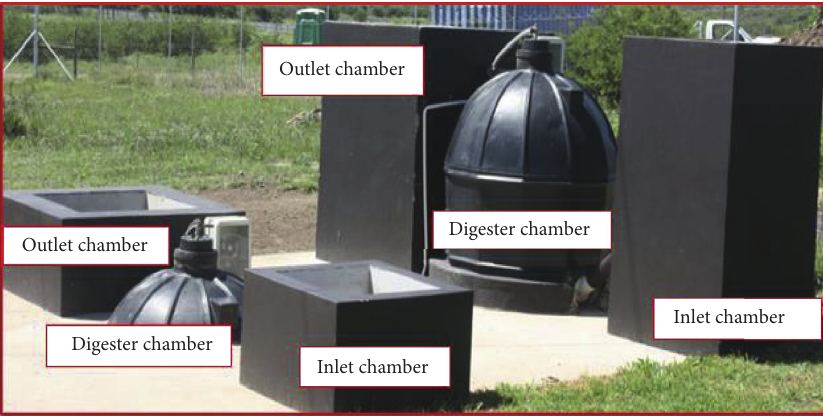
Figure 2: The designed installed biogas digester [13]. Table 2: Properties of fresh cow dung used in the study [13].